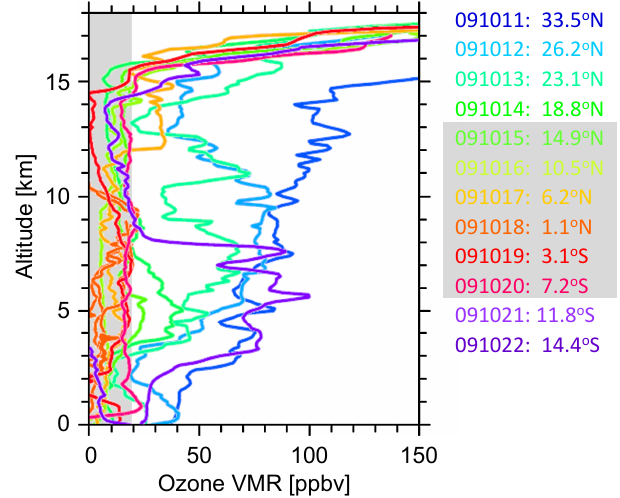
Fig. 1. Western Pacific tropospheric ozone mixing ratios from bal- loon sondes as a function of altitude. The legend shows date and lat- itude of each sounding. Gray shading indicates detection limit (left) and soundings with ozone abundances mostly below the detection limit (right).